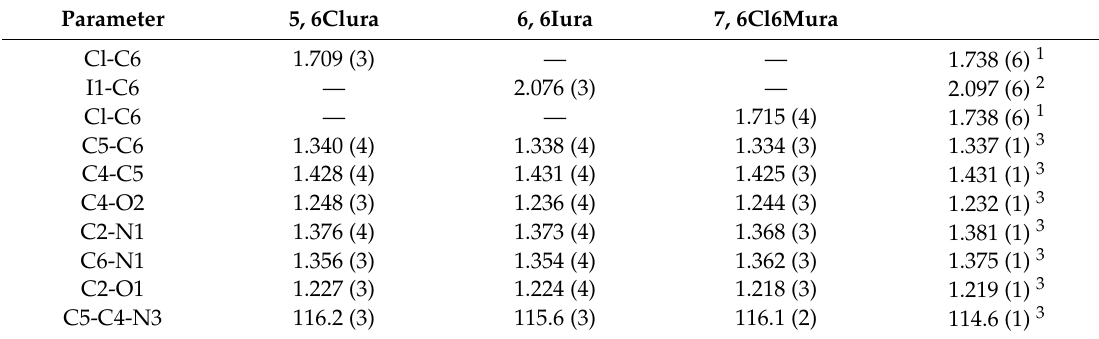
Table 4. Selected geometrical parameters (Å, ◦ ) for compounds 5–7.